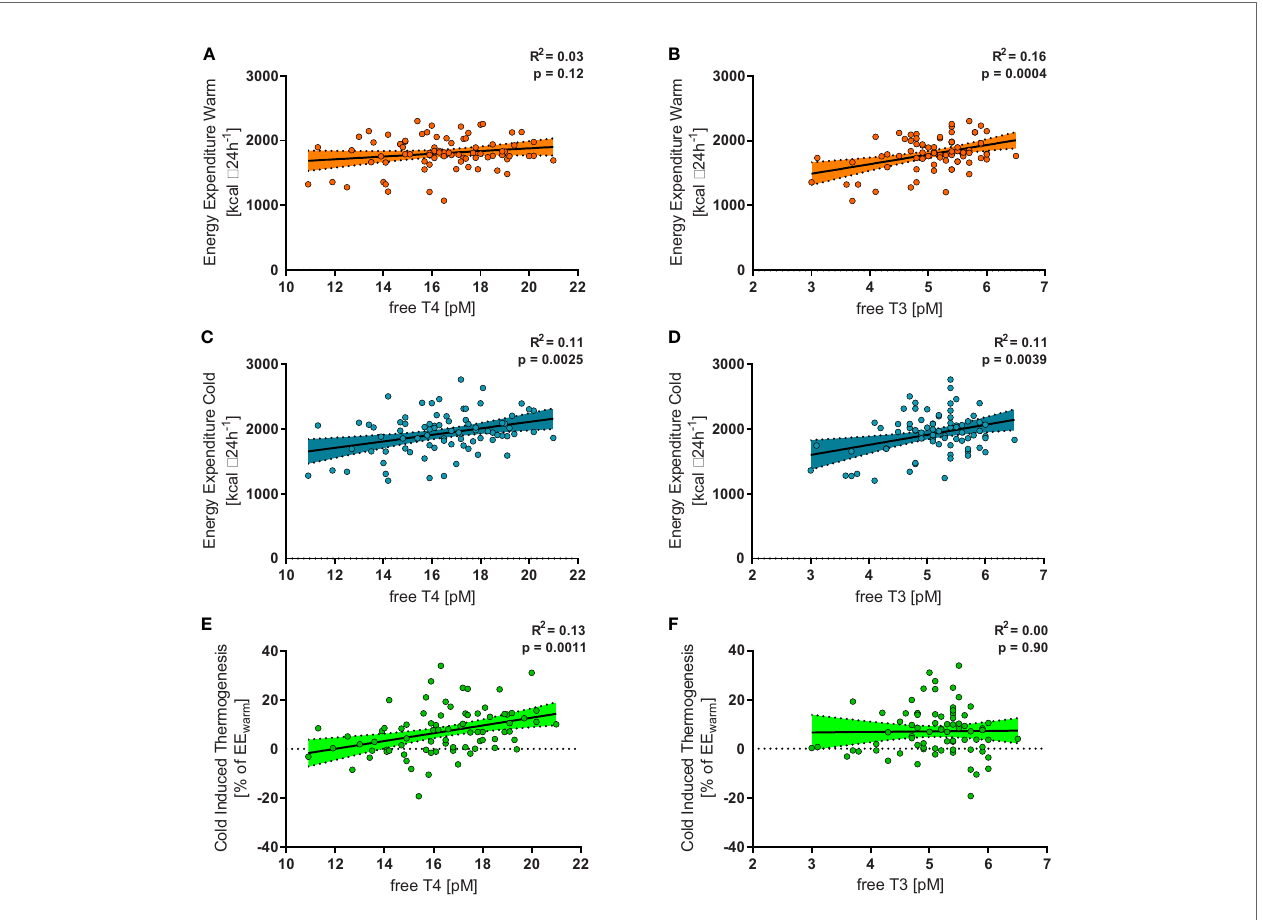
FIGURE 2 | Free T4 within the reference range was not signi fi cantly related to energy expenditure during warm conditions (EE warm , R 2 = 0.03, p=0.12, (A) , but to energy expenditure during mild cold exposure (EE cold , R 2 = 0.11, p=0.0025, (B) and to relative cold induced thermogenesis (CIT, R 2 = 0.13, p=0.0011, (C) . Free T3 was signi fi cantly associated with EE warm (R 2 = 0.16, p=0.0004, (D) , EE cold (R 2 = 0.11, p=0.0039, (E) , but not with CIT (R 2 = 0.00, p=0.90, (F)